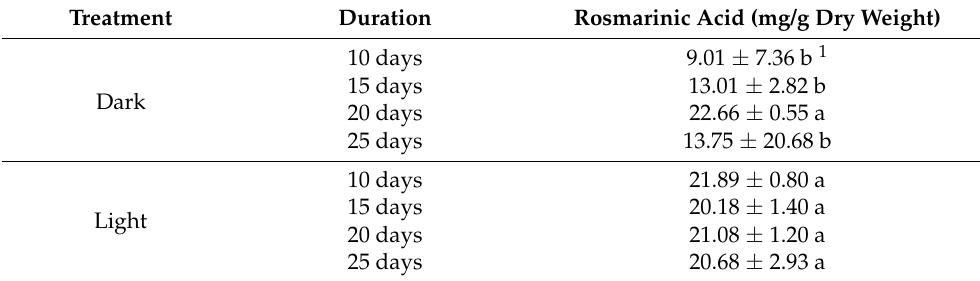
Table 2. Production of rosmarinic acid in P . frutescens microgreens grown under long-day photoperiod or continuous darkness conditions.